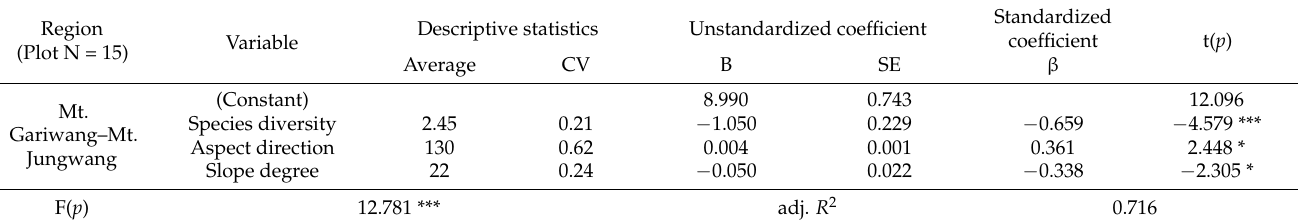
Table 4. The relationship between Abies nephrolepis density and environmental factors.